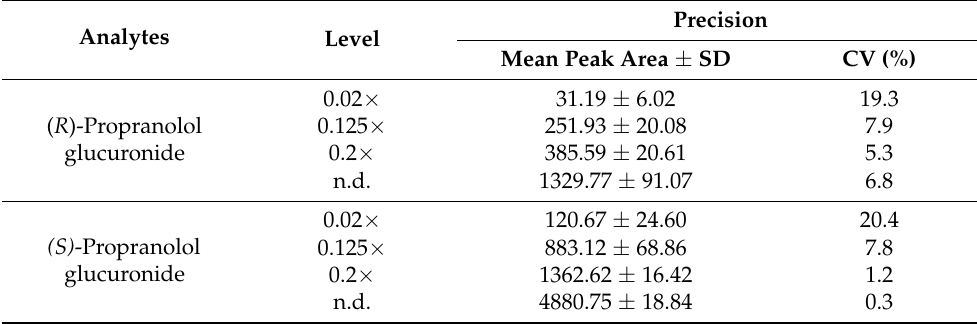
Table 3. Precision of ( R )-propranolol glucuronide and (S)-propranolol glucuronide (n.d. represents the non-diluted incubation samples of propranolol with enzyme bags of isoform UGT1A9). Precision Analytes Level Mean Peak Area ±